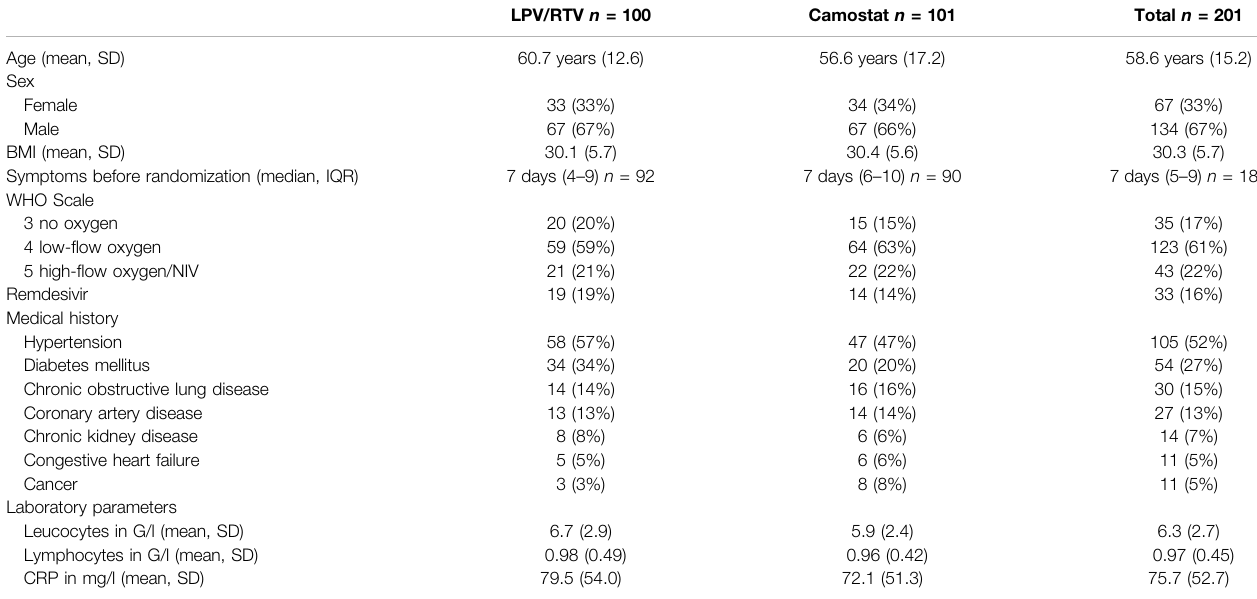
TABLE 1 | Baseline characteristics at randomization.